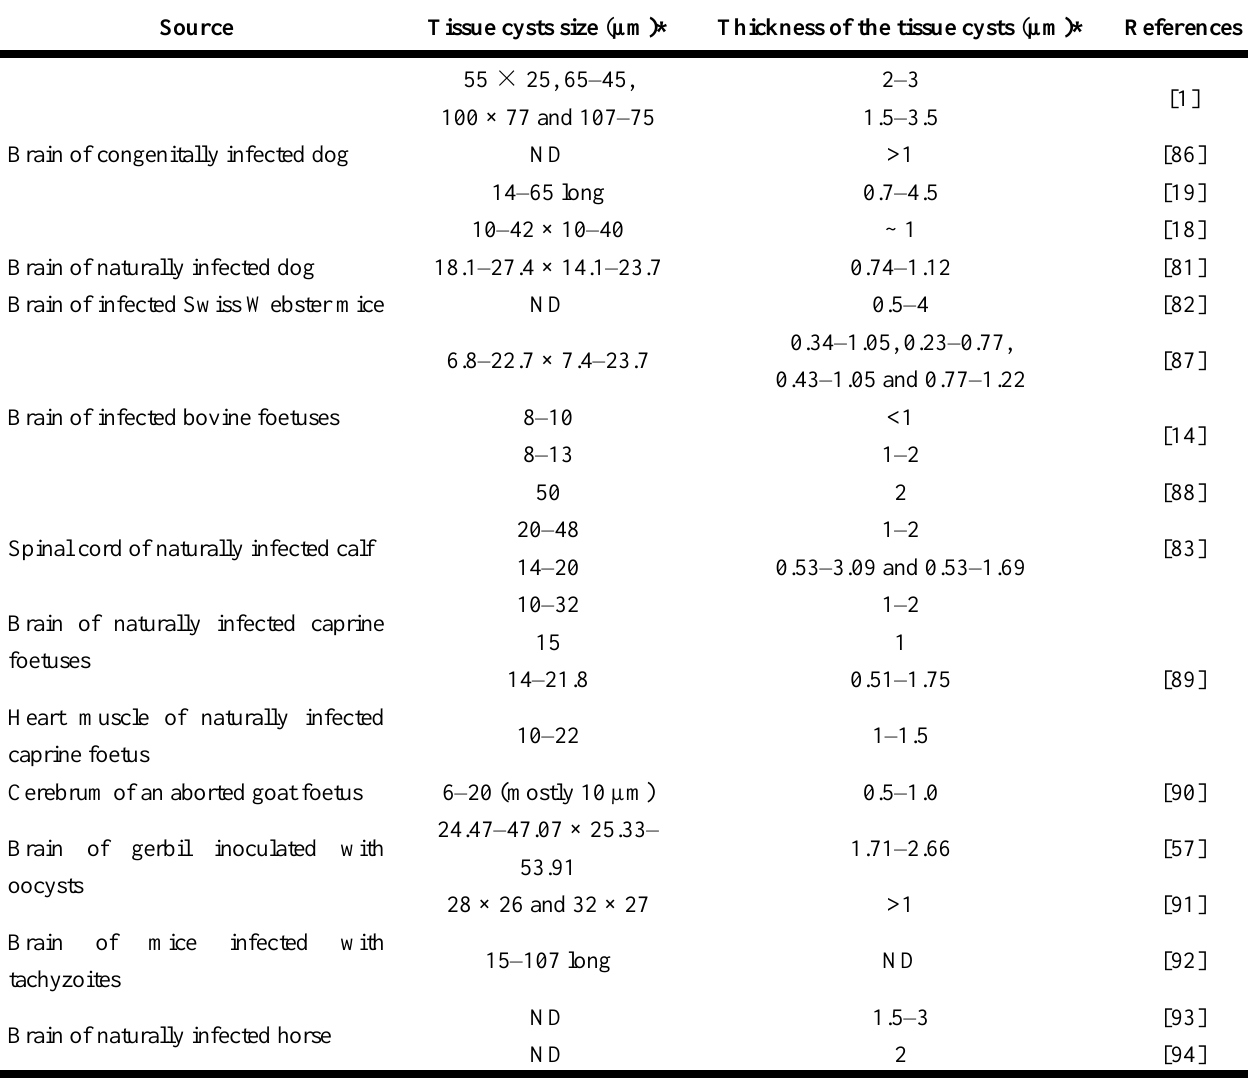
Table 4. Size of tissue cysts of Neospora caninum reported in different infected